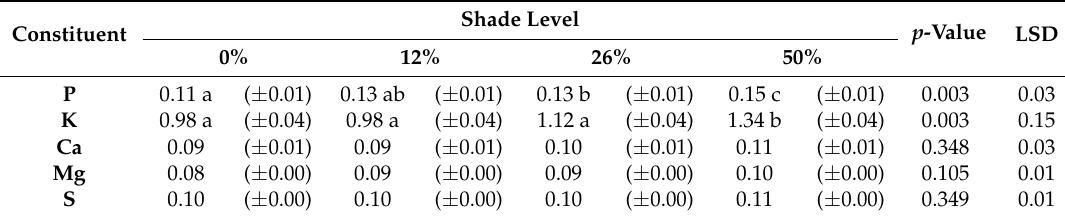
Table 5. Average content of macronutrients (% of dry matter) phosphorus (P), potassium (K), calcium (Ca), magnesium (Mg), and sulfur (S) for the different shade levels (0%, 12%, 26%, and 50%) over the three experimental years